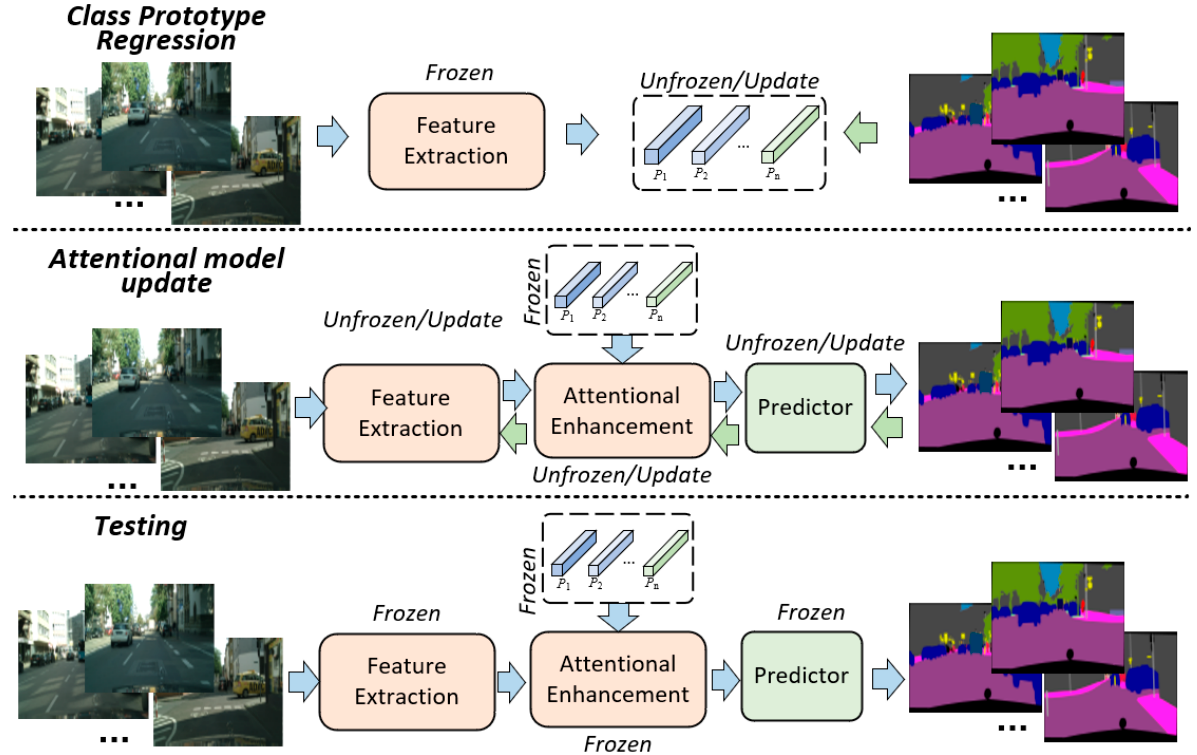
Figure 2. The visualization of the main steps in training and testing APMNet.